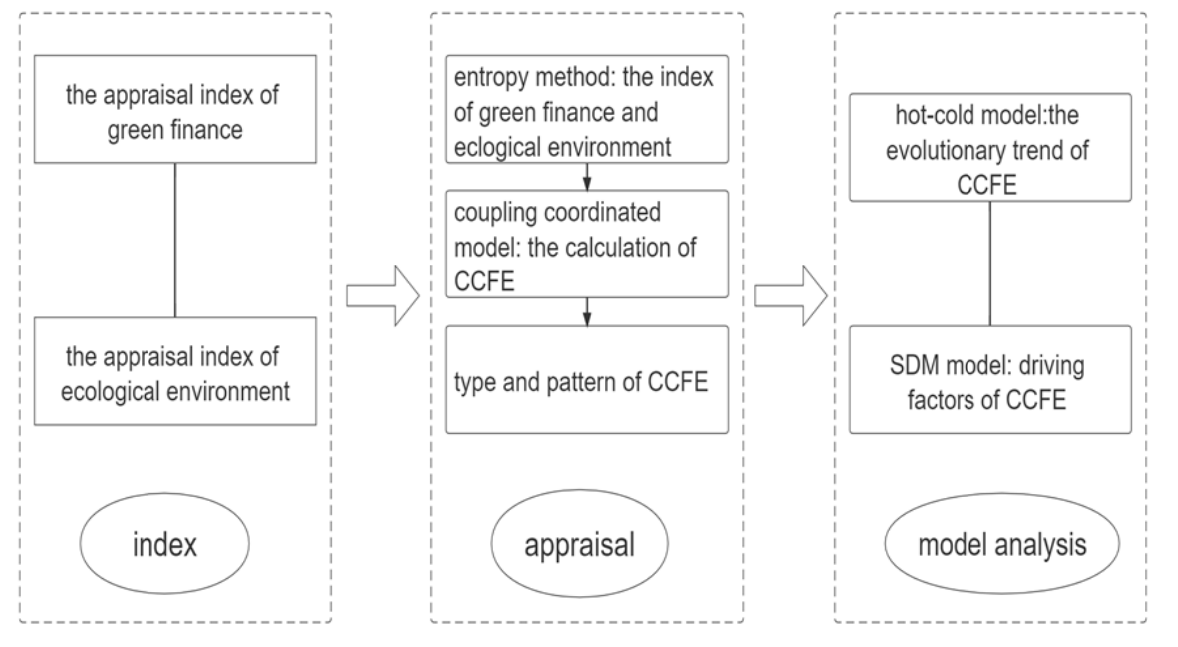
Figure 1. The technological path of this article.